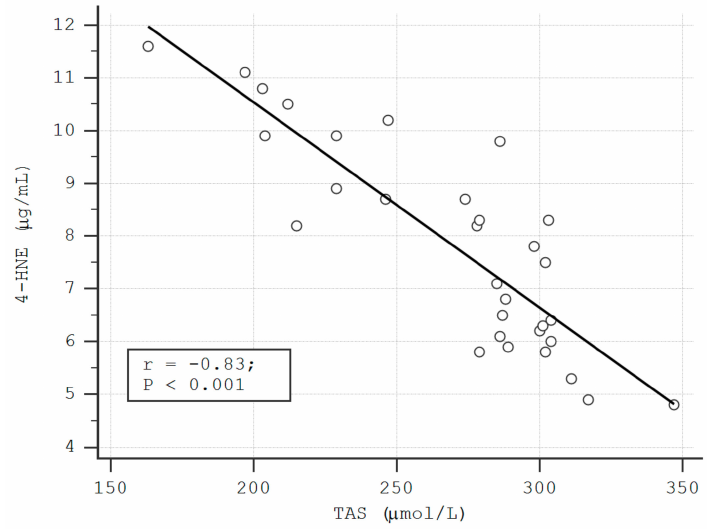
Figure 1. The correlation between the serum levels of 4- HNE and total antioxidant status (TAS) in LP